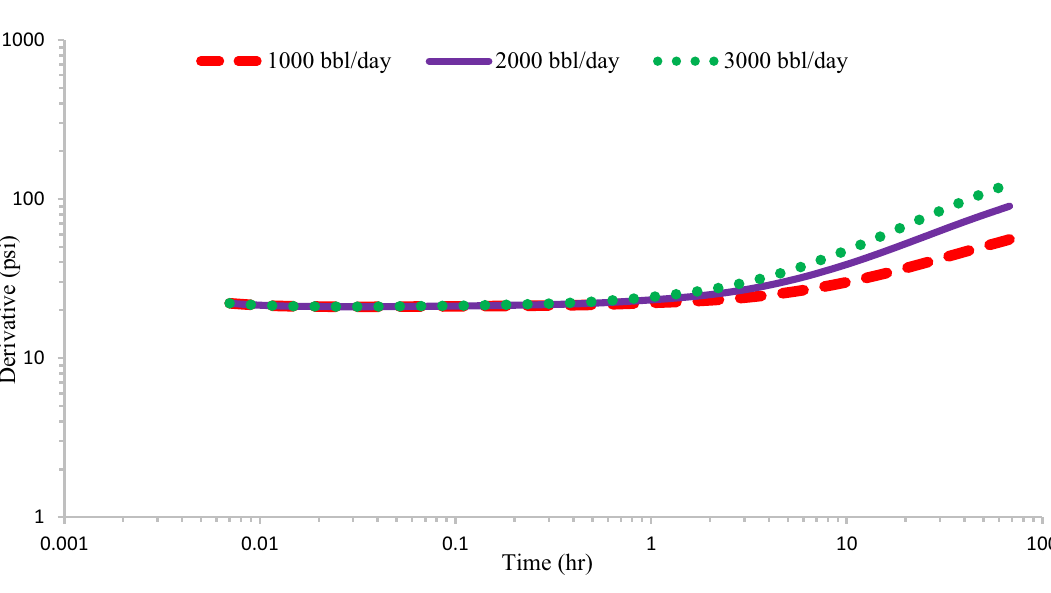
Fig. 10 Sensitivity analysis of scenario No. 3 on the rate and time production of the adjacent well in homogenous